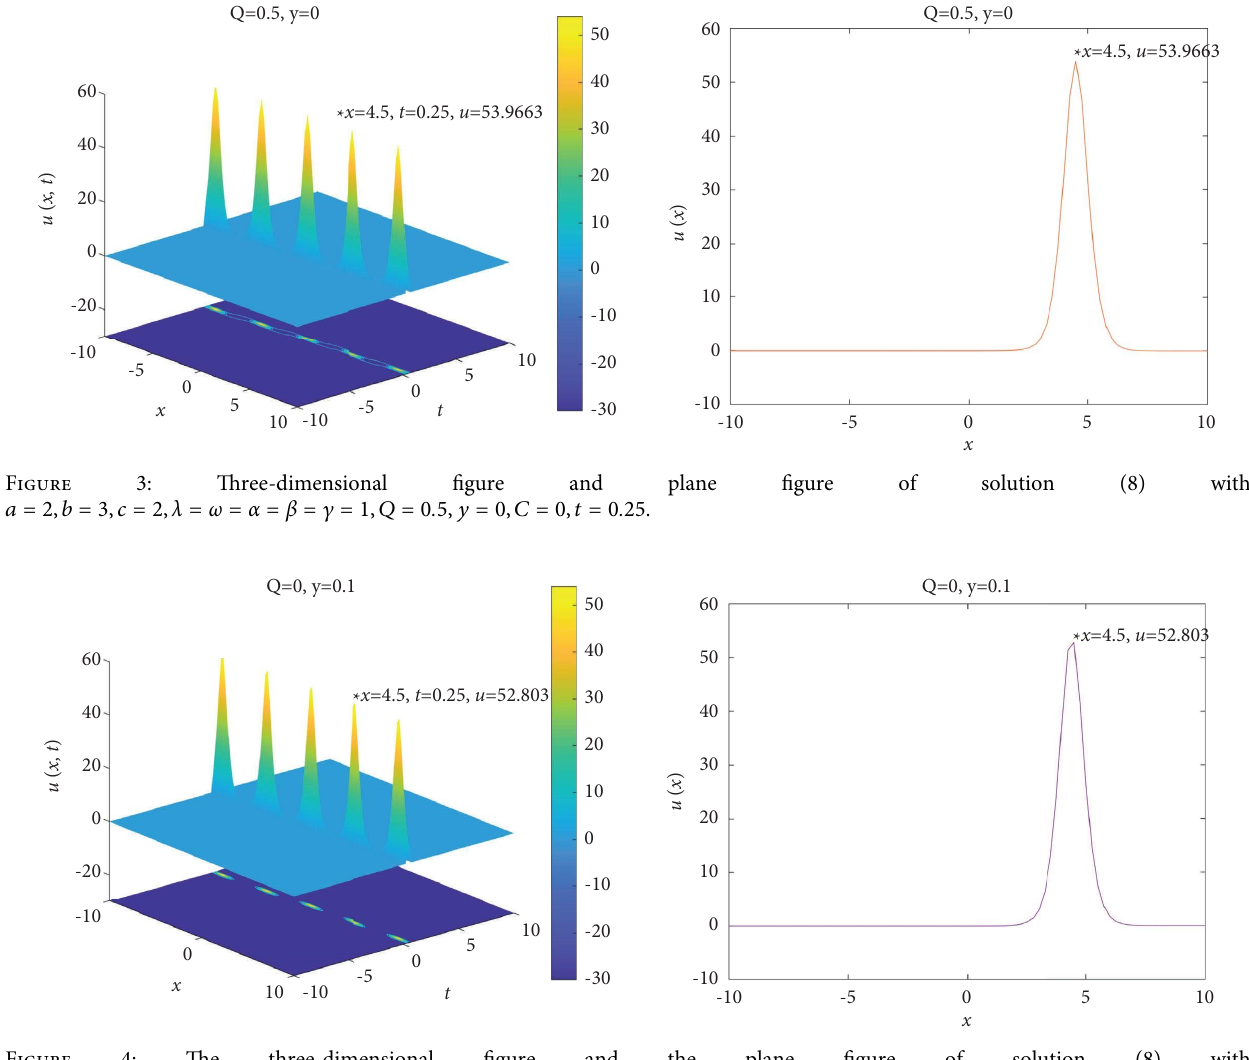
4: Te three-dimensional fgure